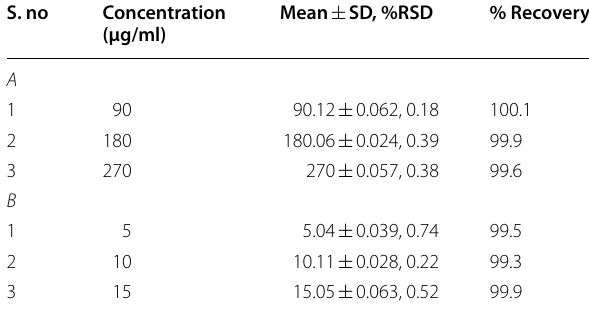
Table 3 UPLC results of accuracy of (A) Bempedoic acid and (B)